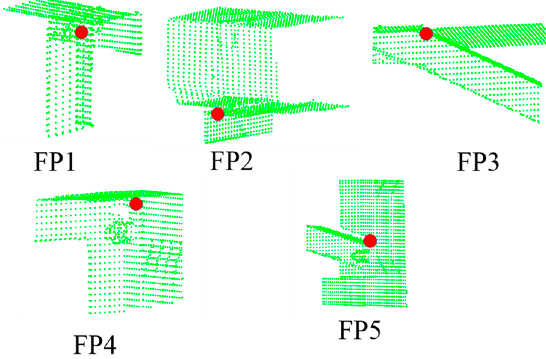
Figure 20. Schematic diagram of the sub models and related feature points.